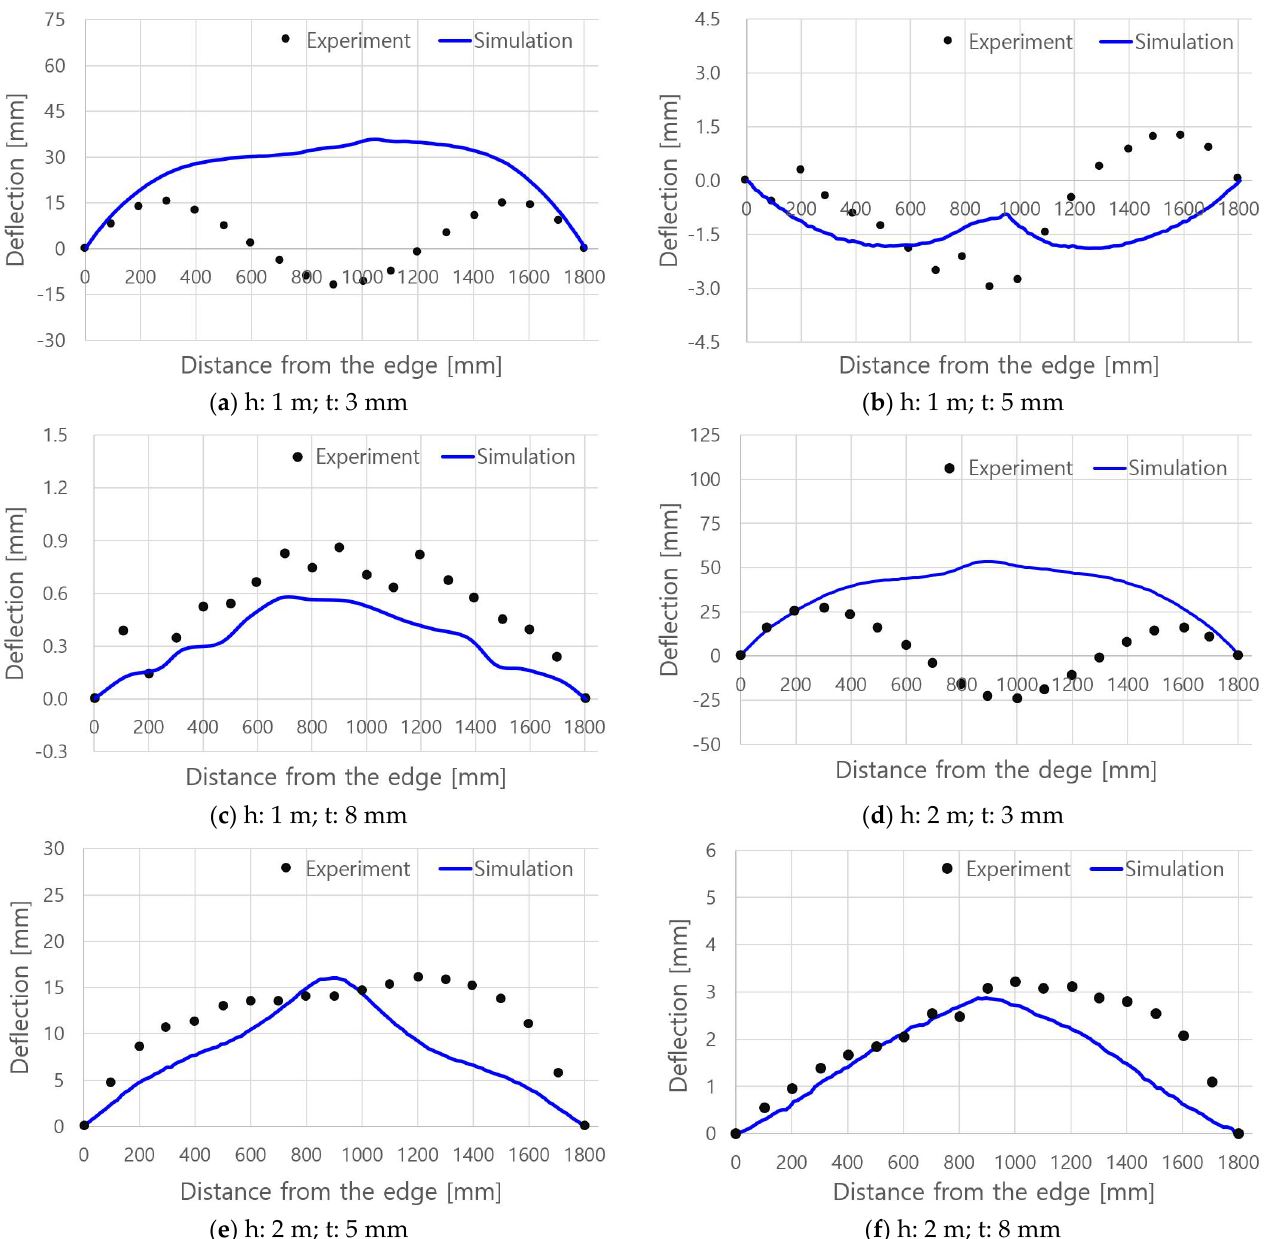
Figure 12. Comparison of relative plastic deflections between experiment and simulation.